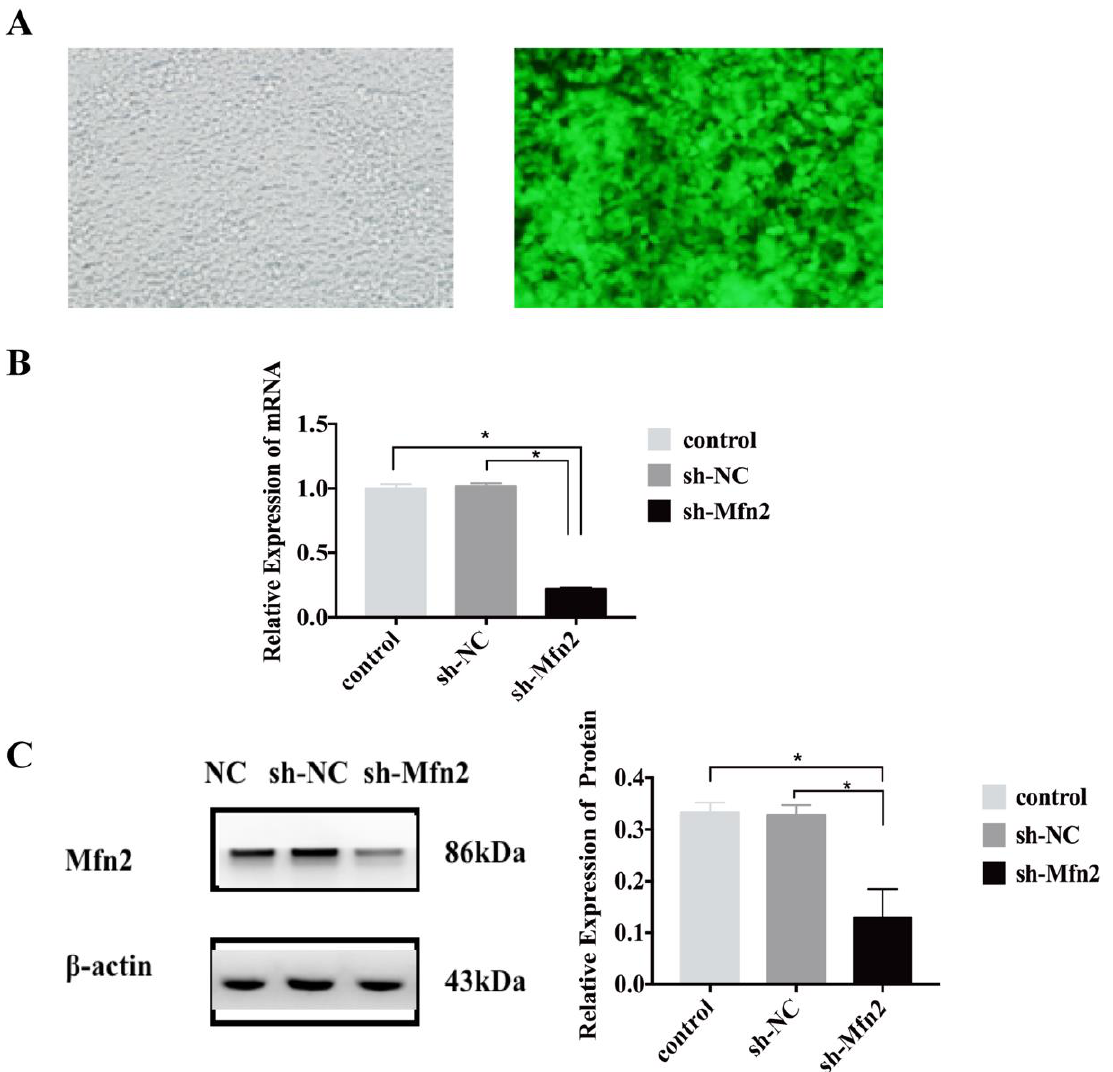
Figure 3. Inhibition of Mfn2 expression. ( A ) Viral titer detection after the inhibition of Mfn2. Left: bright field, 200×; Right: green fluorescence field, 200×; detected cells: 293T cells. ( B ) After the sh-Mfn2 and sh-NC lentiviruses were transfected into stem cells, the mRNA level of Mfn2 was detected by qRT-PCR. ( C ) After the sh-Mfn2 and sh-NC lentiviruses were transfected into stem cells, the protein expression level of Mfn2 was detected by western blot. * p < 0.05. All of the experiments were repeated three times.